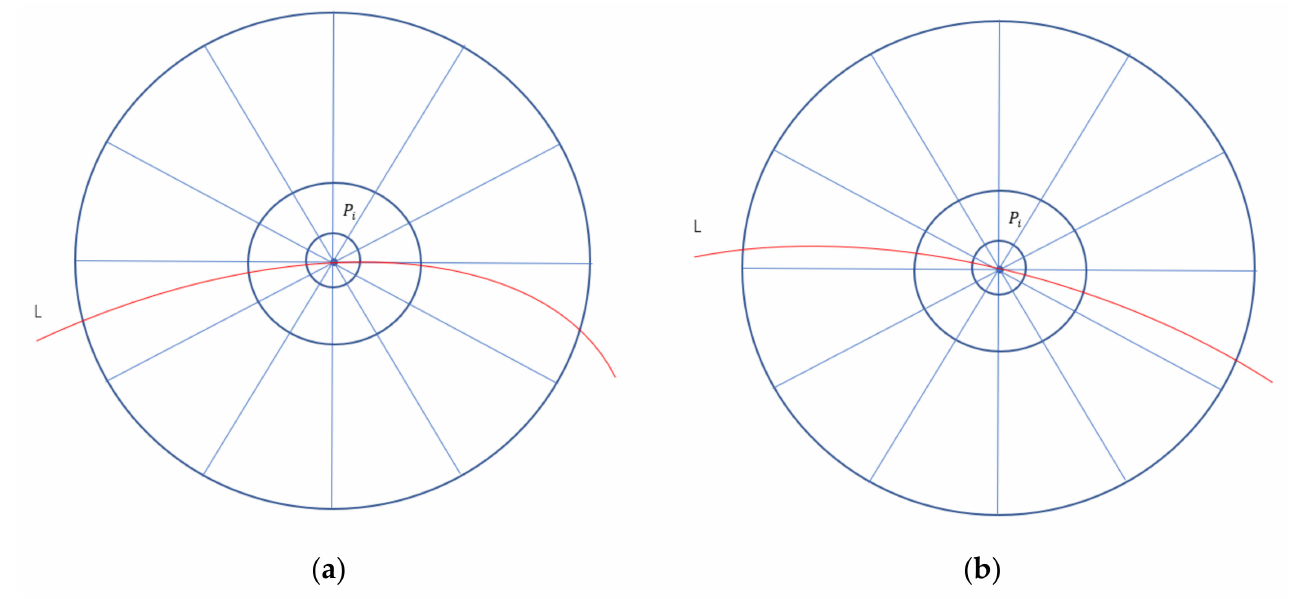
Figure 4. ( a ) is CSR of CBOCD, ( b ) is Ambiguity of ( a